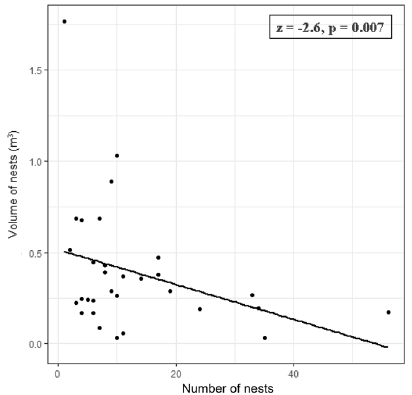
Figure 3. Scatterplot with fitted regression line illustrating the relationship between the number of F. polyctena nests and their